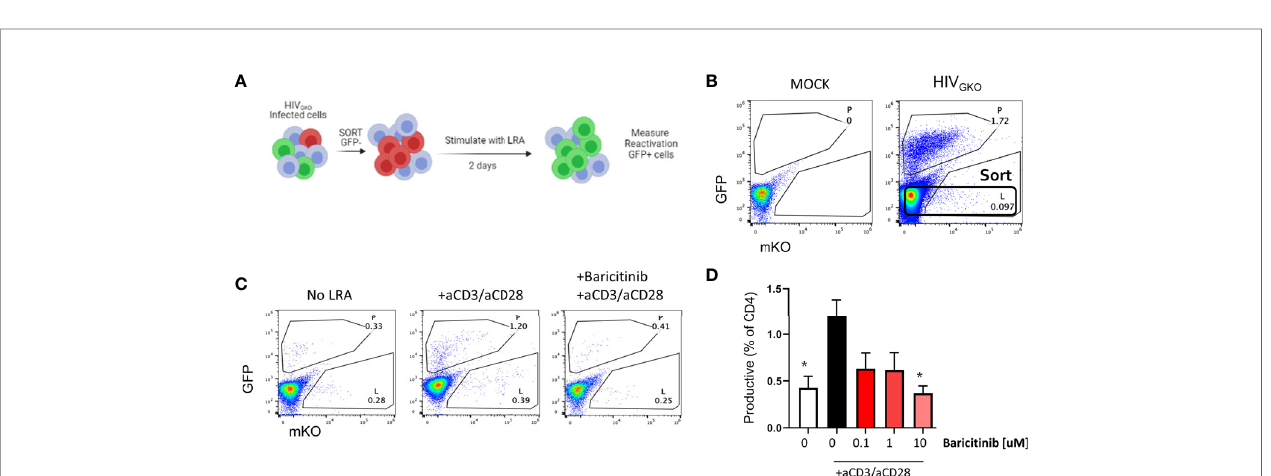
FIGURE 7 | Baricitinib inhibits viral reactivation in latent HIV GKO infected CD4 + T cells. (A) Schematic showing experimental design for sorting and re-activation of HIV GKO in puri fi ed tonsillar CD4 + T cells. (B) Representative fl ow plot showing expression of dual fl uorescent reporters from HIV GKO on day 3 post-infection and the sorting gate for reactivation experiments. (C) Dot plots showing expression of dual fl uorescent reporters from HIV GKO on day 2 following in vitro reactivation. (D) Summary bar graph showing average frequency of GFP + (productive) cells on day 2 post-LRA treatment in presence of Baricitinib at different concentrations. Error bars represent standard error of the mean (SEM), students t test was used to compare all conditions against the no drug control (white bar), *p < 0.05. Results shown represent 3 independent